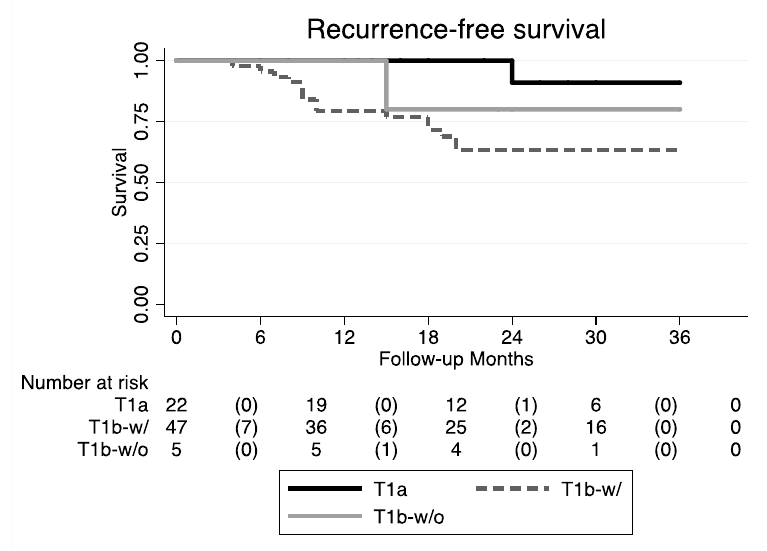
Figure 4. RFS Kaplan – Meier curves (T1b-w/: T1b with AC involvement; T1b-w/o: T1b without AC involvement).